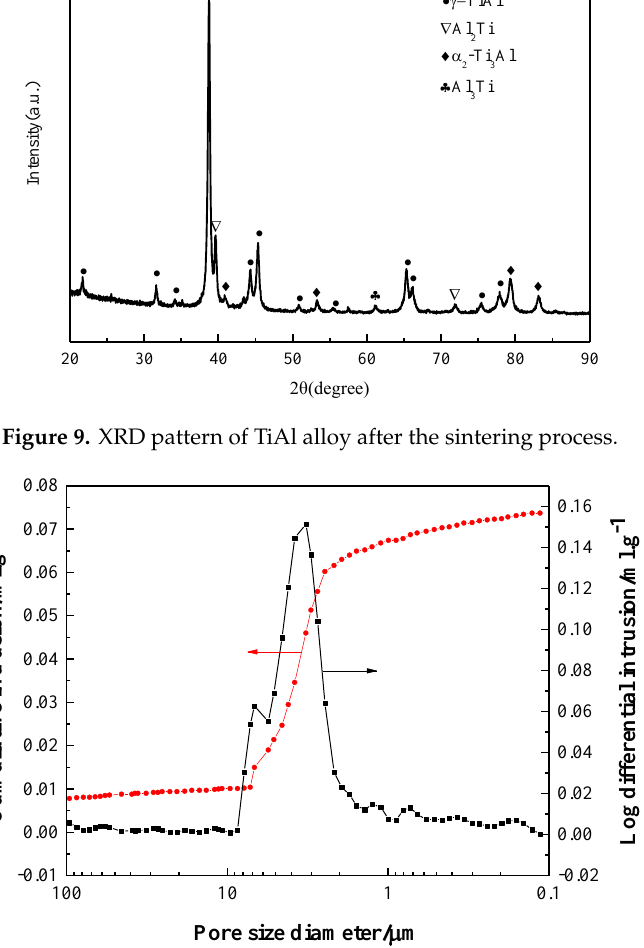
Figure 10. Pore size distribution of the TiAl alloy sintered at 1400 °C in vacuum for 2 h.